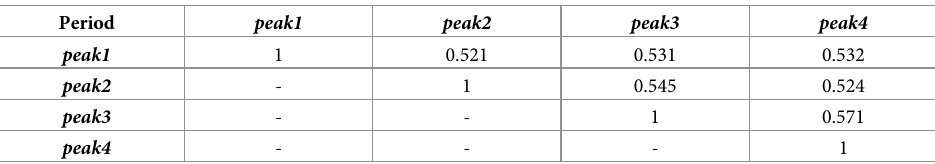
Table 4. Community structures